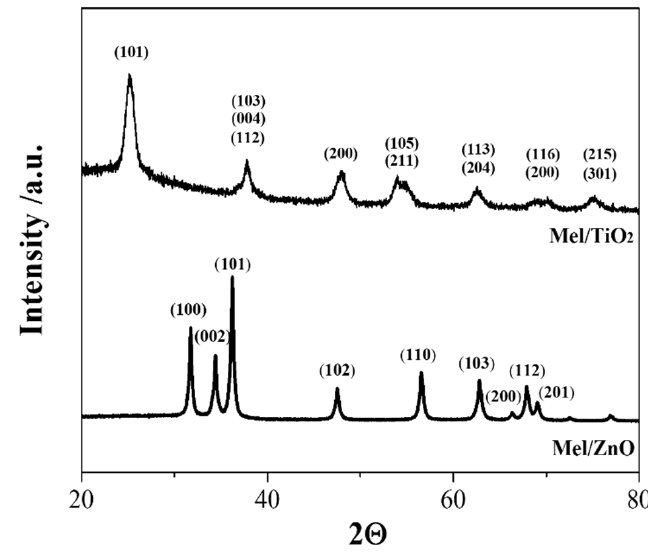
Figure 1. XRD spectra of Mel/TiO 2 and Mel/ZnO nanoparticles.